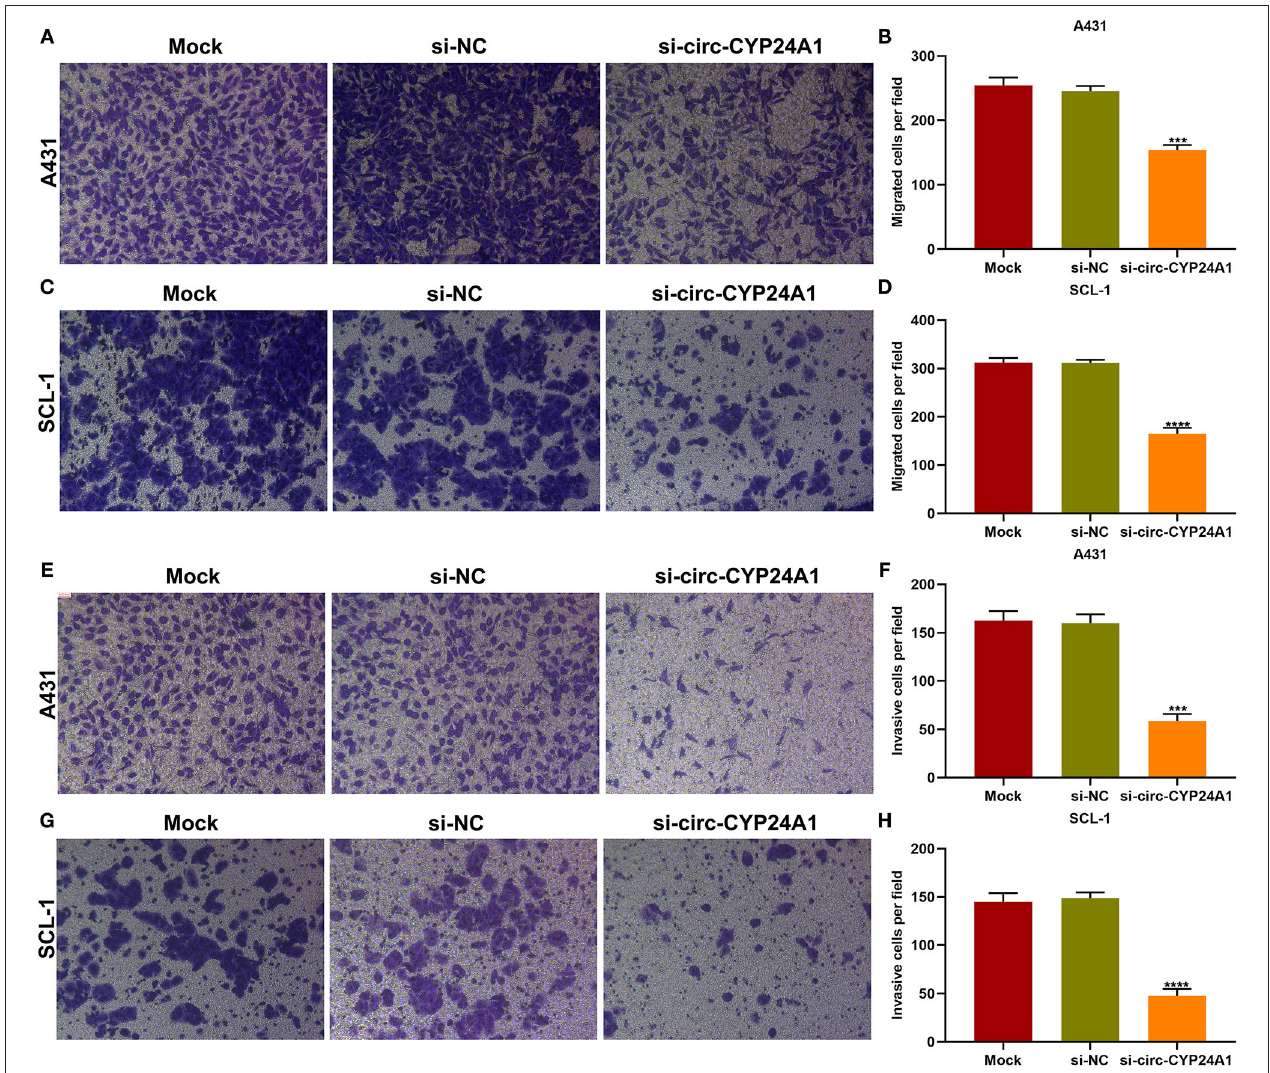
FIGURE 8 | The roles of exosomal circ-CYP24A1 on migrated and invasive abilities of cSCC cells. (A-D) The number of migrated (A,B) A431 cells and (C,D) SCL-1 cells under incubation with si-circ-CYP24A1-transfected exosomes. (E-H) The number of invasive (E,F) A431 cells and (G,H) SCL-1 cells when incubated with si-circ-CYP24A1-transfected exosomes. *** P -value < 0.001; **** p -value < 0.0001.